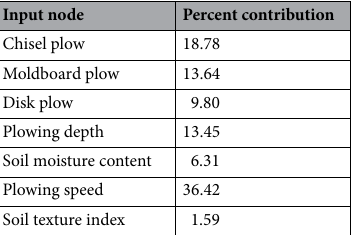
Table 5. Contribution percentage of independent variables used in the ANN model for prediction of tractor rear wheel slip during tillage